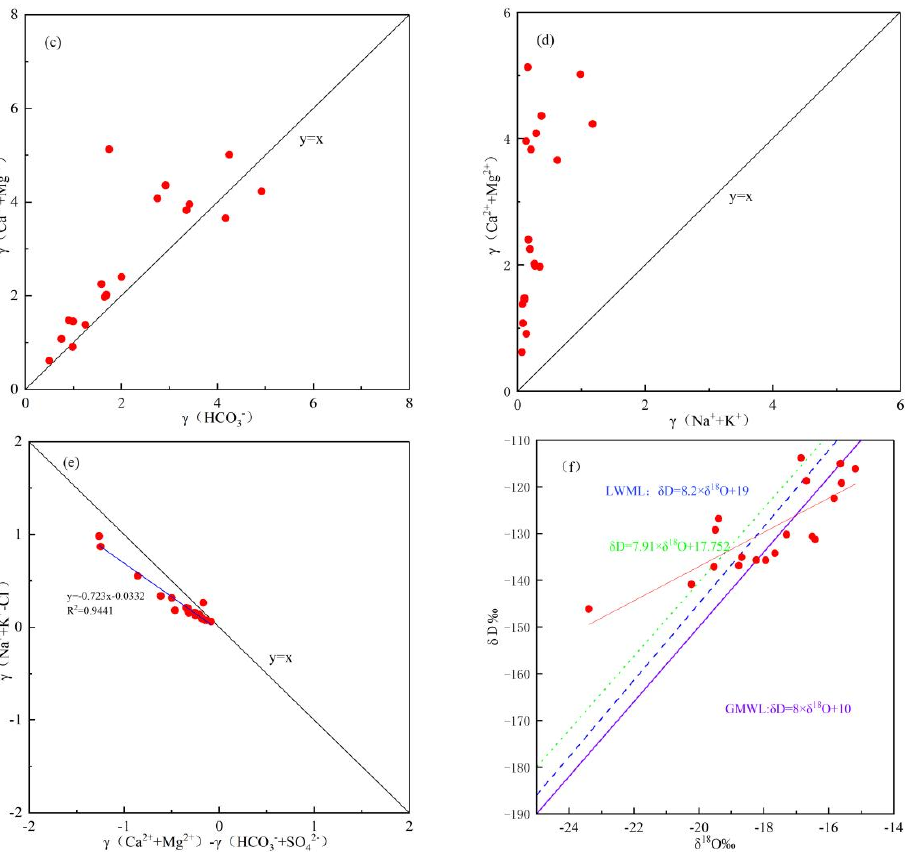
Figure 6. The ratio diagram of main ions in the natural water in the study area ( a ) γ (Na + + K + )/ γ (Cl − ); ( b ) γ (Ca 2+ + Mg 2+ )/ γ (HCO 3 − + SO 42 − ); ( c ) γ (Ca 2+ + Mg 2+ )/ γ (HCO 3 − ); ( d ) γ Ca 2+ + Mg 2+ )/ γ (Na + + K + ); ( e ) γ [(Na + + K + ) – Cl − ]/[ γ (Ca 2+ + Mg 2+ ) − γ (HCO 3 − + SO 42 − )]; ( f ) δ D/ δ 18 O.